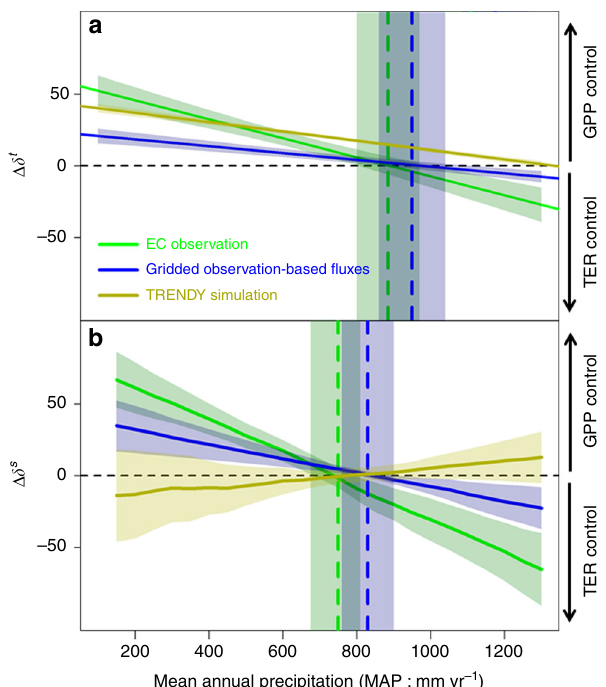
Fig. 2 Sensitivity of ecosystem production and respiration to precipitation showed a threshold behavior. Sensitivity of ecosystem production (GPP) and respiration (TER) to precipitation showed a threshold behavior in both observation-constrained dataset (in green and blue), but not in TRENDY DGVM simulation (in olive). The Y axis ( Δ δ t for temporal sensitivities or Δ δ s for spatial sensitivities in units of gC m − 2 yr − 1 in response to 100-mm change in precipitation) is calculated as the difference between the sensitivity of GPP to precipitation and the sensitivity of TER to precipitation (cid:2) δ t (cid:2) δ s for both temporal ( a , Δ δ t ¼ δ t ) and spatial ( b , Δ δ s ¼ δ s ) GPP TER GPP TER sensitivity. Because the sensitivity of TER ( δ t or δ s ) to precipitation is TER TER always positive, a positive value ( Δ δ t or Δ δ s ) indicates that GPP is more sensitive to precipitation than TER to precipitation anomalies. Shaded areas are the mean ± one standard